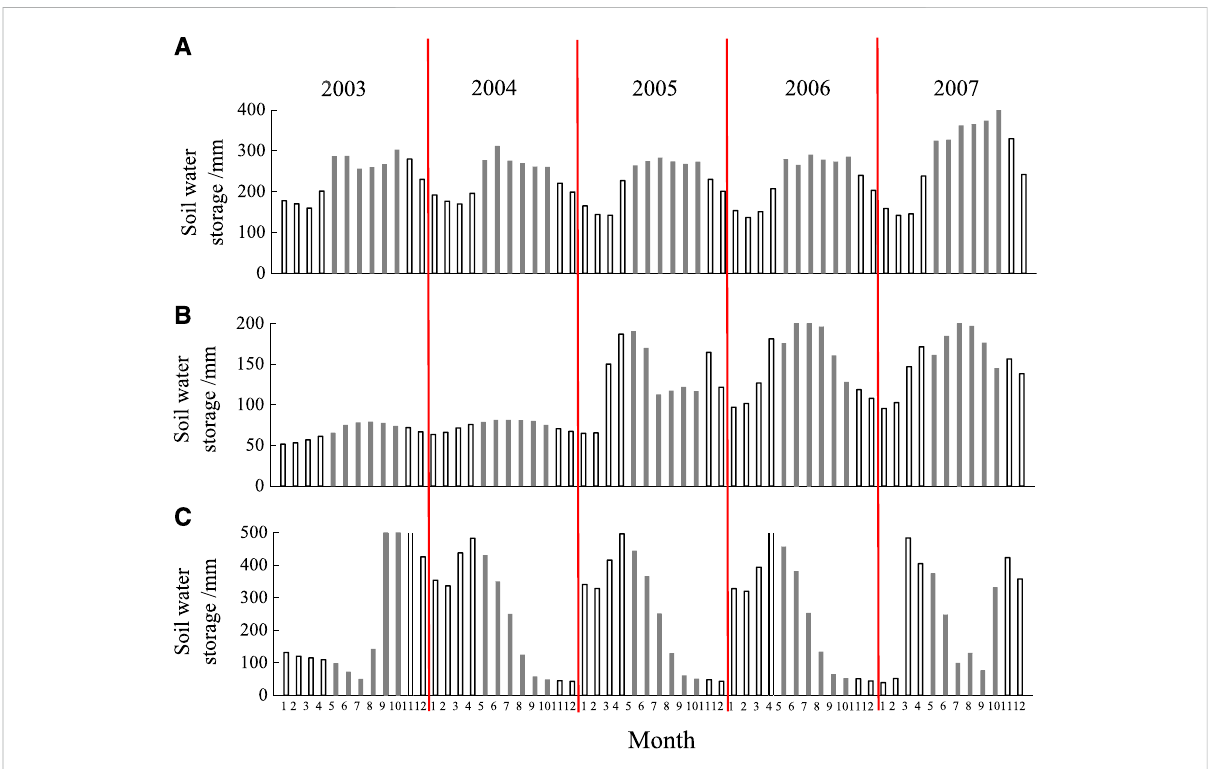
FIGURE 4 Monthly variations in soil water storage. Note: (A – C) represent upstream mountain vegetation zone, midstream arti fi cial shrubbery of desert oasis transition zone, and downstream desert riparian forest zone, respectively. White columns represents non-growing season (January – April, October – November), whereas gray columns represents growing season (May – October).